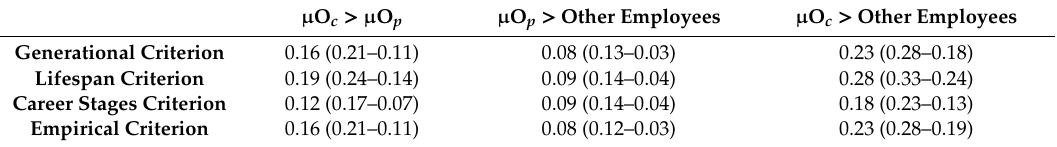
Table 7. E ff ect sizes of group di ff